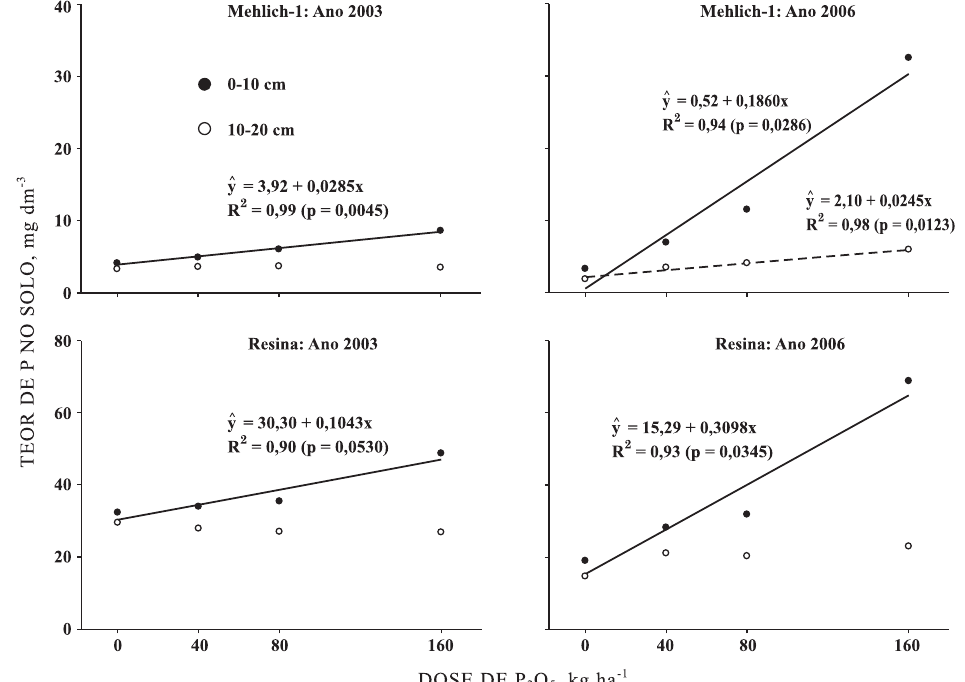
Figura 1. Teores de fósforo (Mehlich-1 e resina trocadora de ânions) nas camadas de 0–10 e 10–20 cm de um Latossolo Bruno após o primeiro (final do 3º ano, 2003) e segundo ciclos (final do 6º ano, 2006) de rotação de culturas na média das fontes (superfosfato triplo-SFT e FNR-Gafsa e Arad) e das doses aplicadas (0, 40, 80 e 160 kg ha -1 P O 2 5